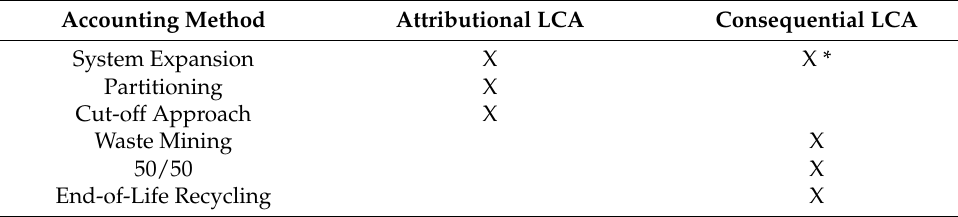
Table 1. Overview of accounting methods per LCA type, based on